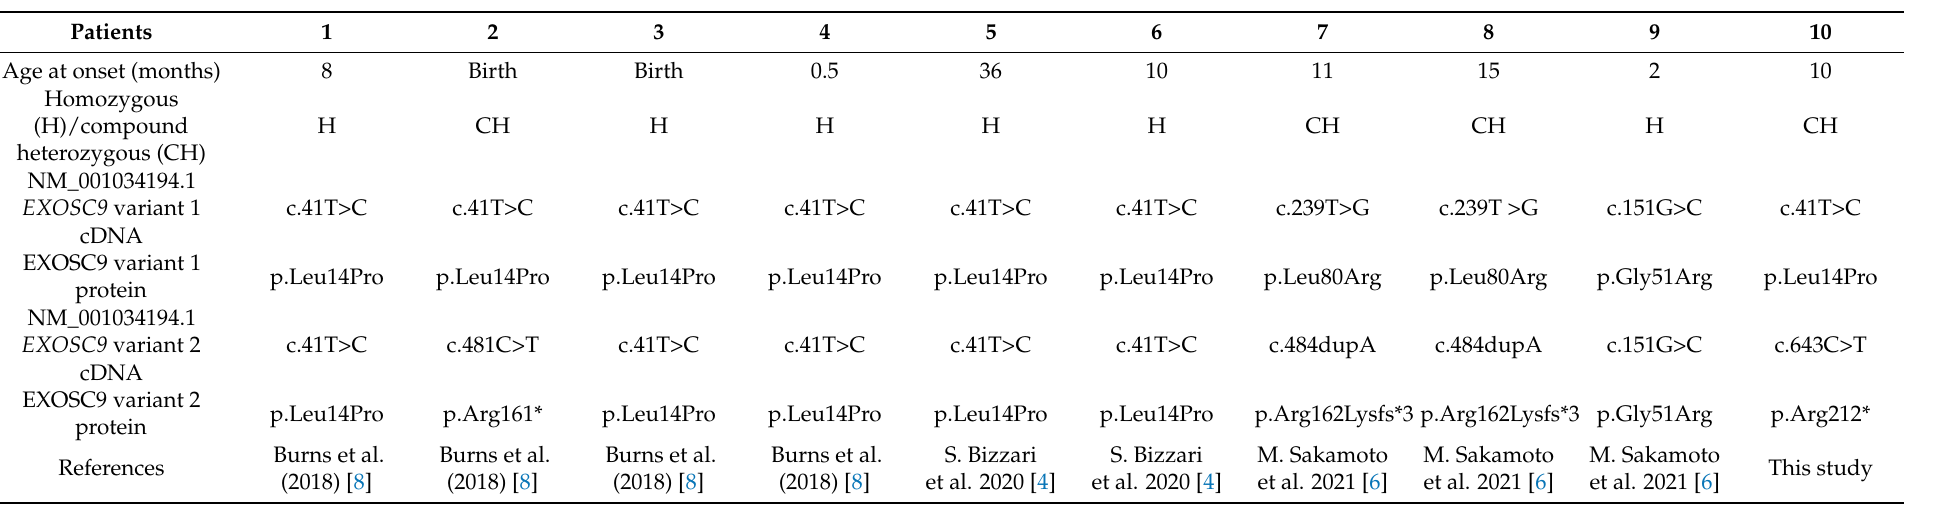
Table 1. Age of onset and molecular findings